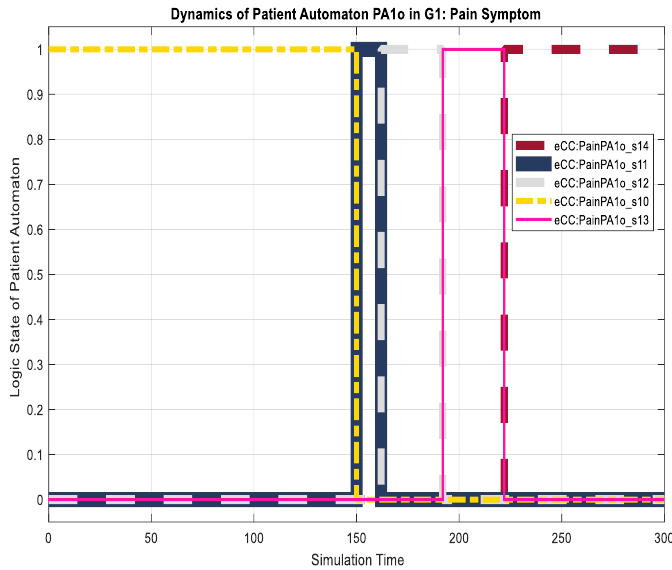
Figure 18. Dynamics of the patient, 𝑷𝑨 𝟏𝑶 , in terms of the pain symptom. Sensors 2018 , 18 , 2531